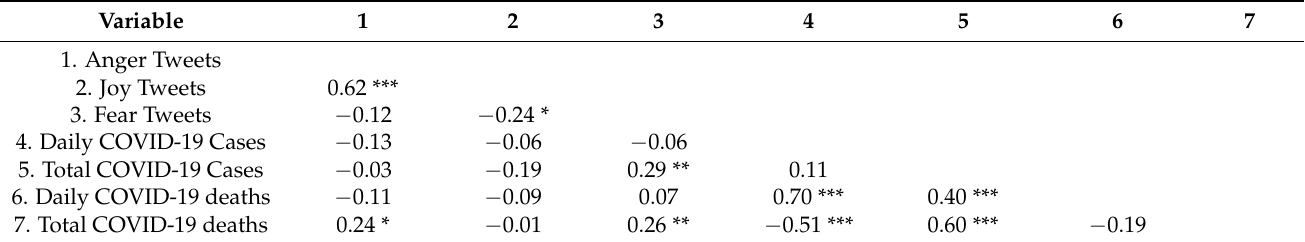
Table A9. Palermo Pearson’s correlation coefficient